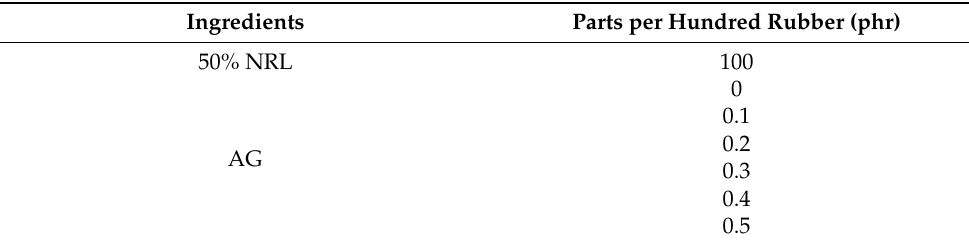
Table 1. Formulations of NRL with variable loadings of